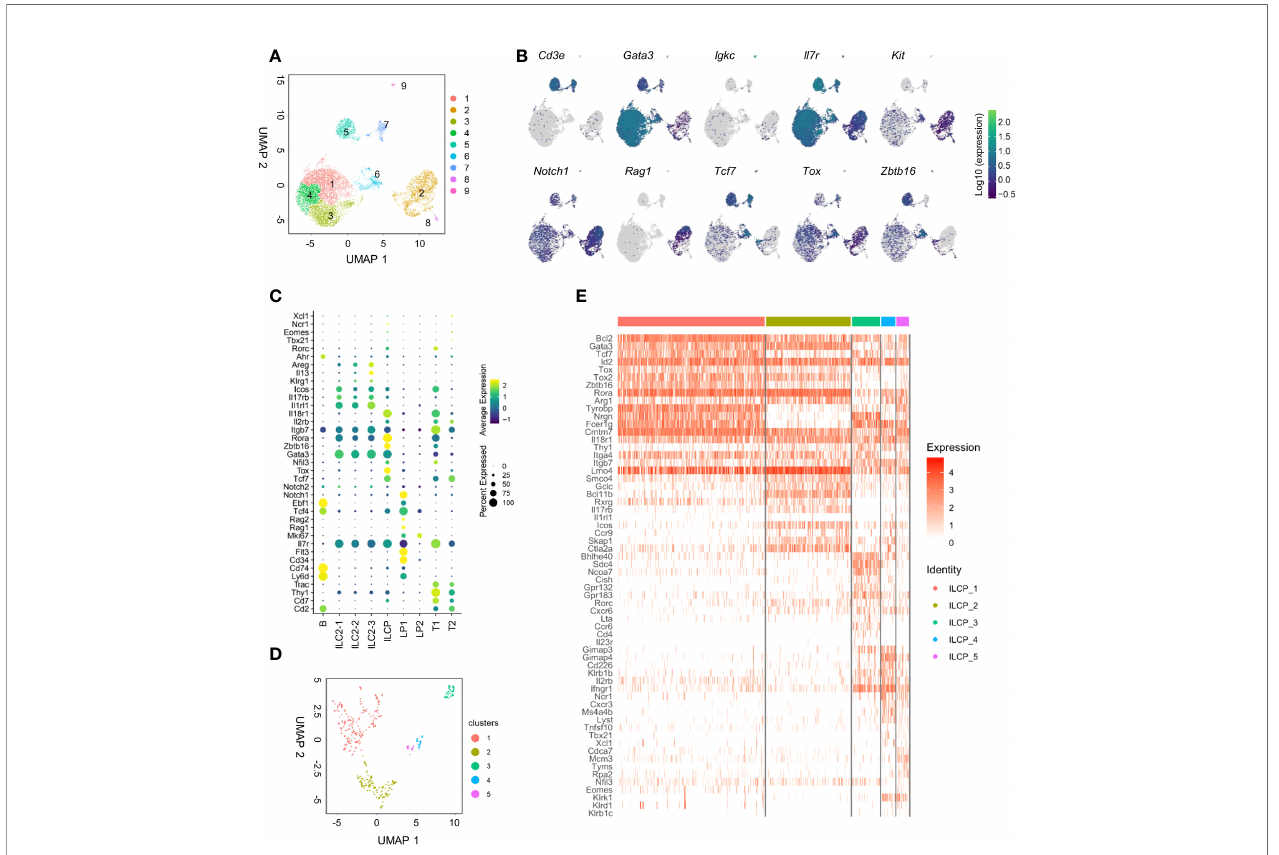
FIGURE 3 | scRNA-seq analysis of adult BM lin - IL7R a + cells reveals the heterogeneity of the IL18R a + population. (A) Lin - IL-7R a + cells sorted from the BM of wild- type mice. UMAP plot shows the distinct clusters within 12,643 sequenced cells. (B) UMAP expression of lymphoid progenitor or ILC-associated genes in clusters in panel (A, C) Expression of candidate genes within BM lin - IL-7R a + cell clusters. (D) UMAP plot of cluster 6 from panel (A, E) Heatmap of selected lymphoid progenitor/ILC-associated genes by 5 clusters in panel (D)